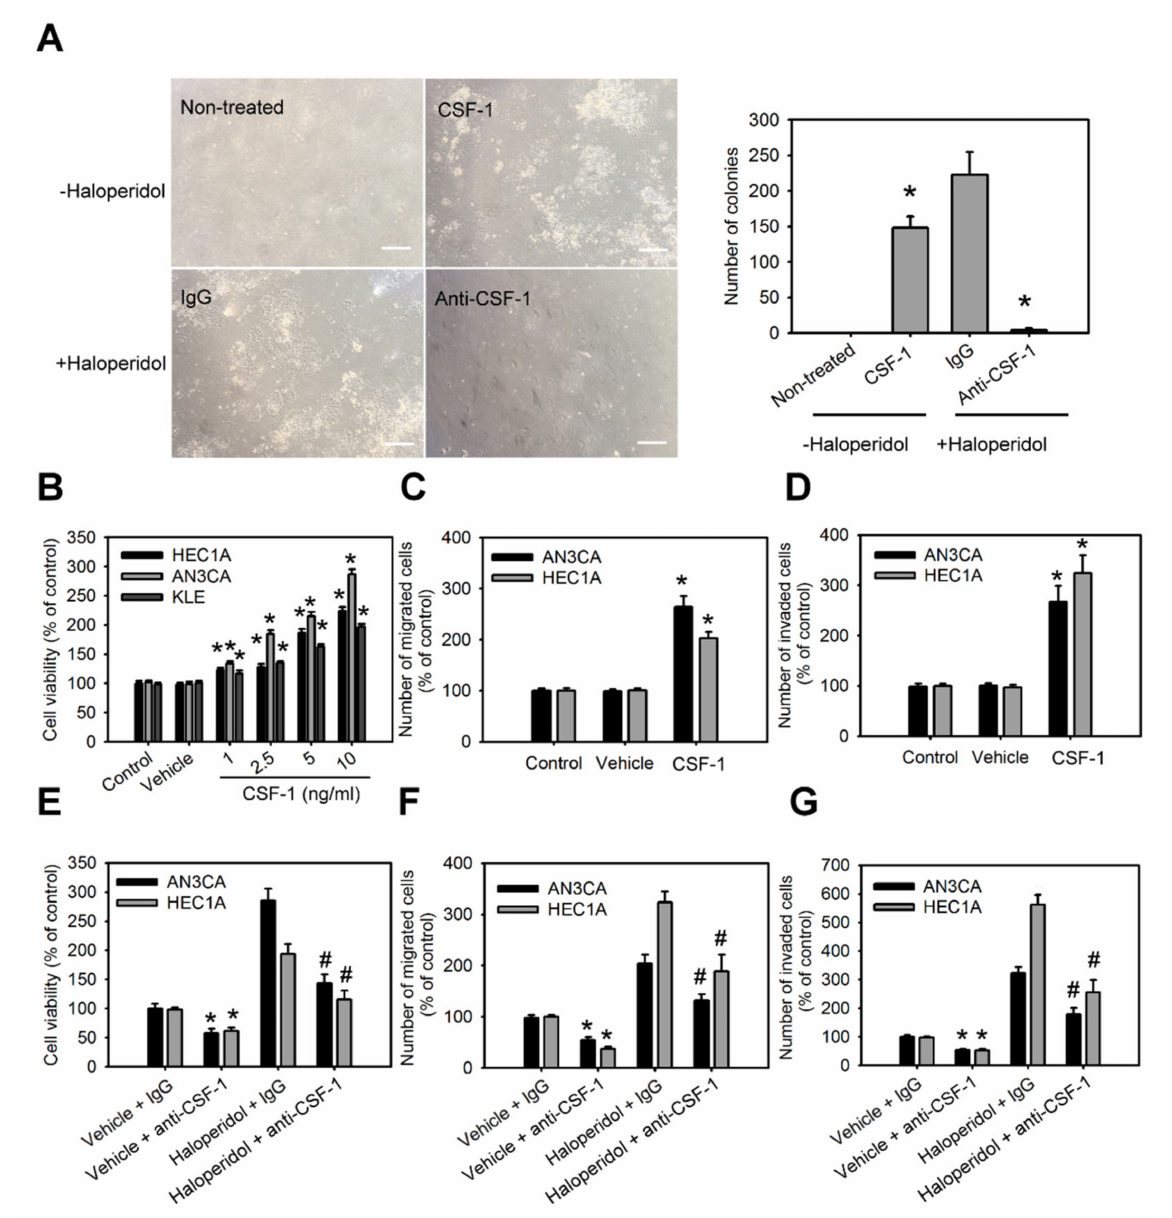
Figure 5. CSF-1/CSF-1R stimulates the cellular transformation of HEECs and the malignant progres- sion of HECCs in vitro. ( A ) The number of colonies formed in soft agar of primary HEECs treated with nothing (control), CSF-1 recombinant protein (10 ng/mL), haloperidol (100 µ M) plus IgG, or haloperidol plus CSF-1 neutralizing antibody (100 ng/mL) for 28 days. Cell viability ( B ), migration ( C ), and invasion ( D ) of HEC1A, AN3CA, and KLE cells treated with nothing (control), vehicle, or CSF-1 recombinant protein (10 ng/mL) for 48 h. Cell viability ( E ), migration ( F ), and invasion ( G ) of HEC1A and AN3CA cells treated with vehicle plus IgG, vehicle plus CSF-1 neutralizing anti- body (100 ng/mL), haloperidol (100 µ M) plus IgG, or haloperidol plus CSF-1 neutralizing antibody (100 ng/mL) for 48 h. Data are presented as means ± SD within triplicate experiments. * p < 0.01, compared with the untreated or vehicle groups (normal saline). # p < 0.001, compared with the controlled IgG